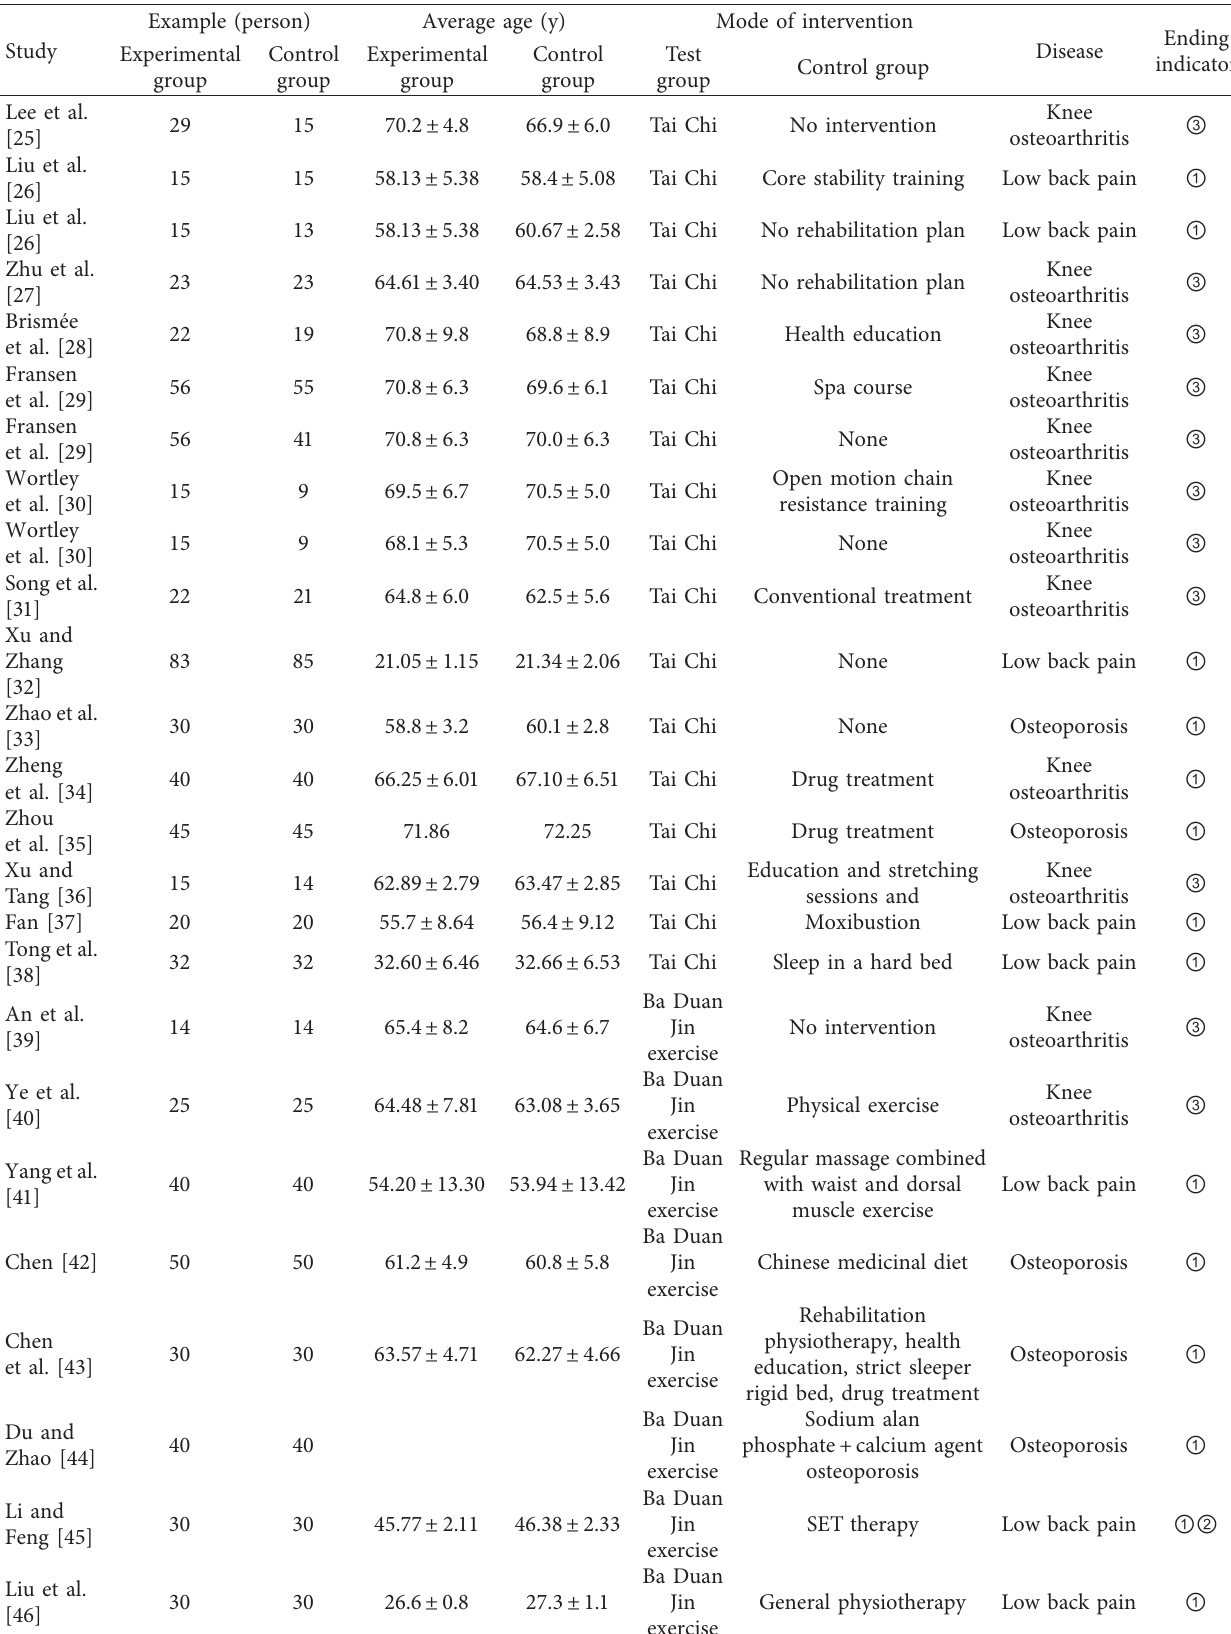
Table 1: Basic characteristics of the included